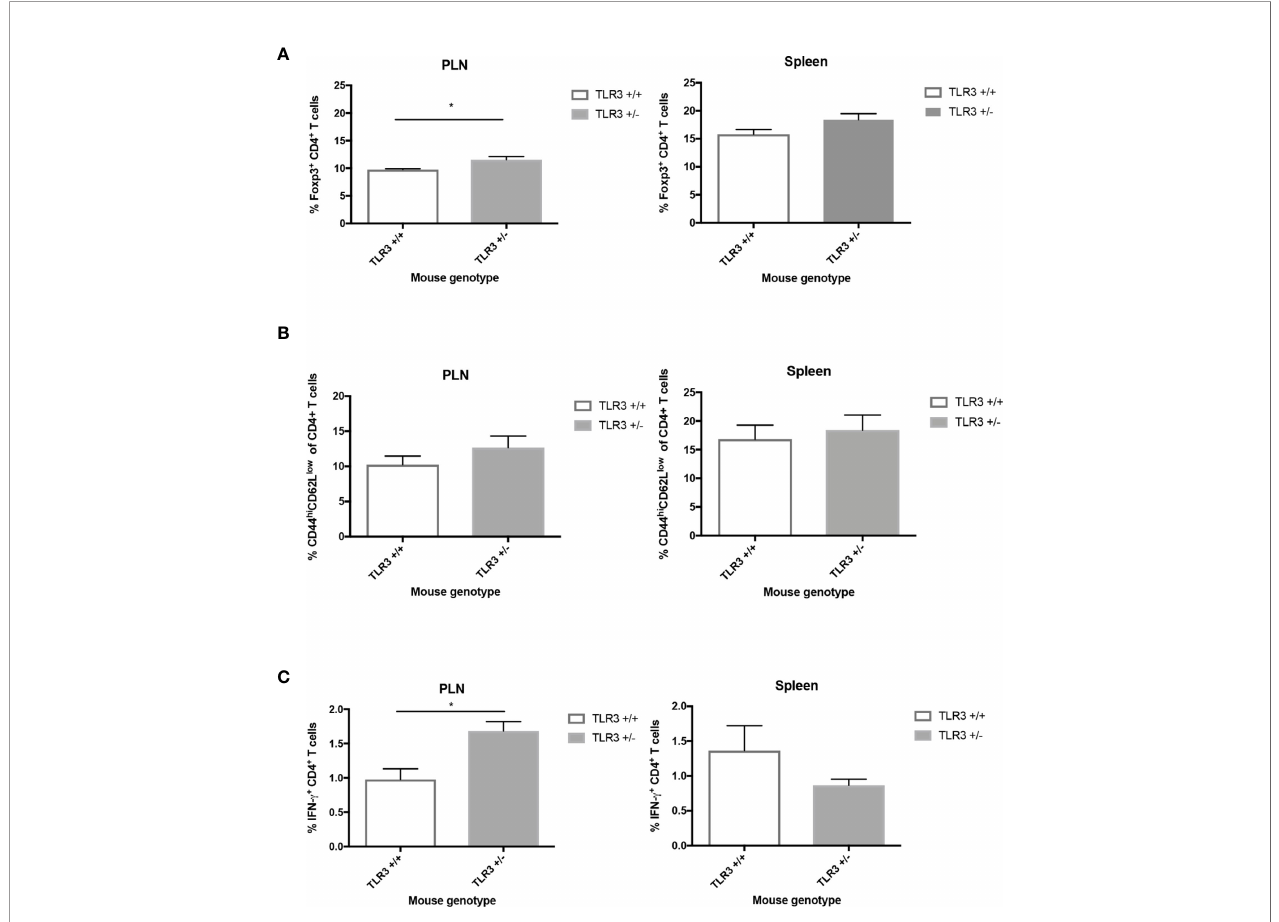
FIGURE 2 | Regulatory and effector CD4+ T cells from the PLNs and spleen of TLR3 +/- and TLR3 +/+ mice post-CB4 infection. (A) Regulatory T cells (Foxp3 + CD4 + ) and (B, C) effector T cells (CD44 hi CD62 low CD4 + and IFN g -producing CD4 + ) were isolated from the pancreatic lymph nodes (PLNs) and spleens of TLR3+/+ (n = 5) and TLR3+/- mice (n = 5) at day 7 post CB4-infection and were stained with classical activation and maturation marker antibodies for FACS analysis. Results are shown as mean ± SEM of a representative from three independent experiments. *p <